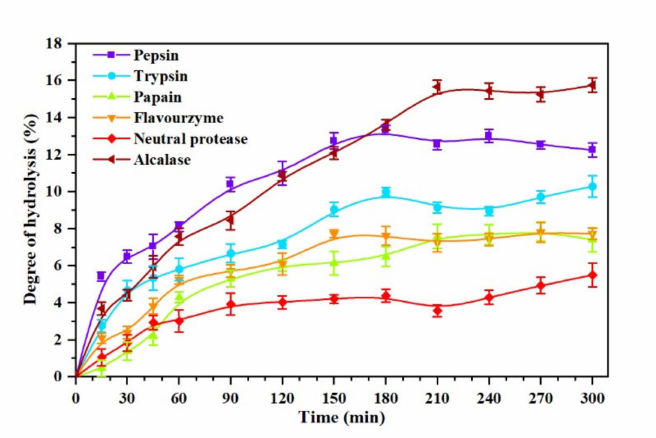
Figure 2. The degree of hydrolysis (DH) curve of the Oviductus Ranae protein hydrolyzed by pepsin, trypsin, papain, flavourzyme, neutral protease and